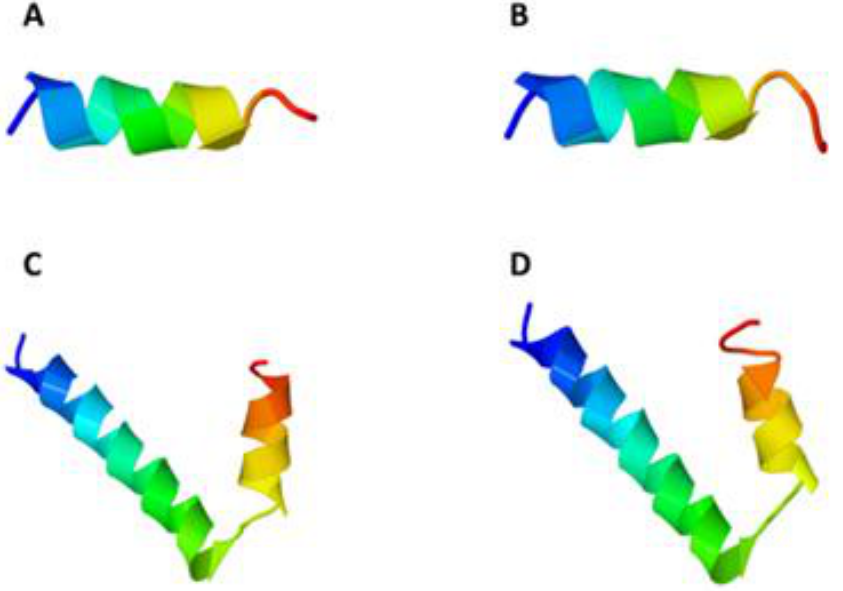
Figure 1. I-TASSER 3D structure prediction of Synoeca without ( A ) and with ( B ) the extra Asp residue, and of CM4 without ( C ) and with ( D ) the extra Asp residue. Images were generated with the Jmol-based Jena3D Viewer (http://jena3d.leibniz-fli.de, accessed on 30 October 2020).